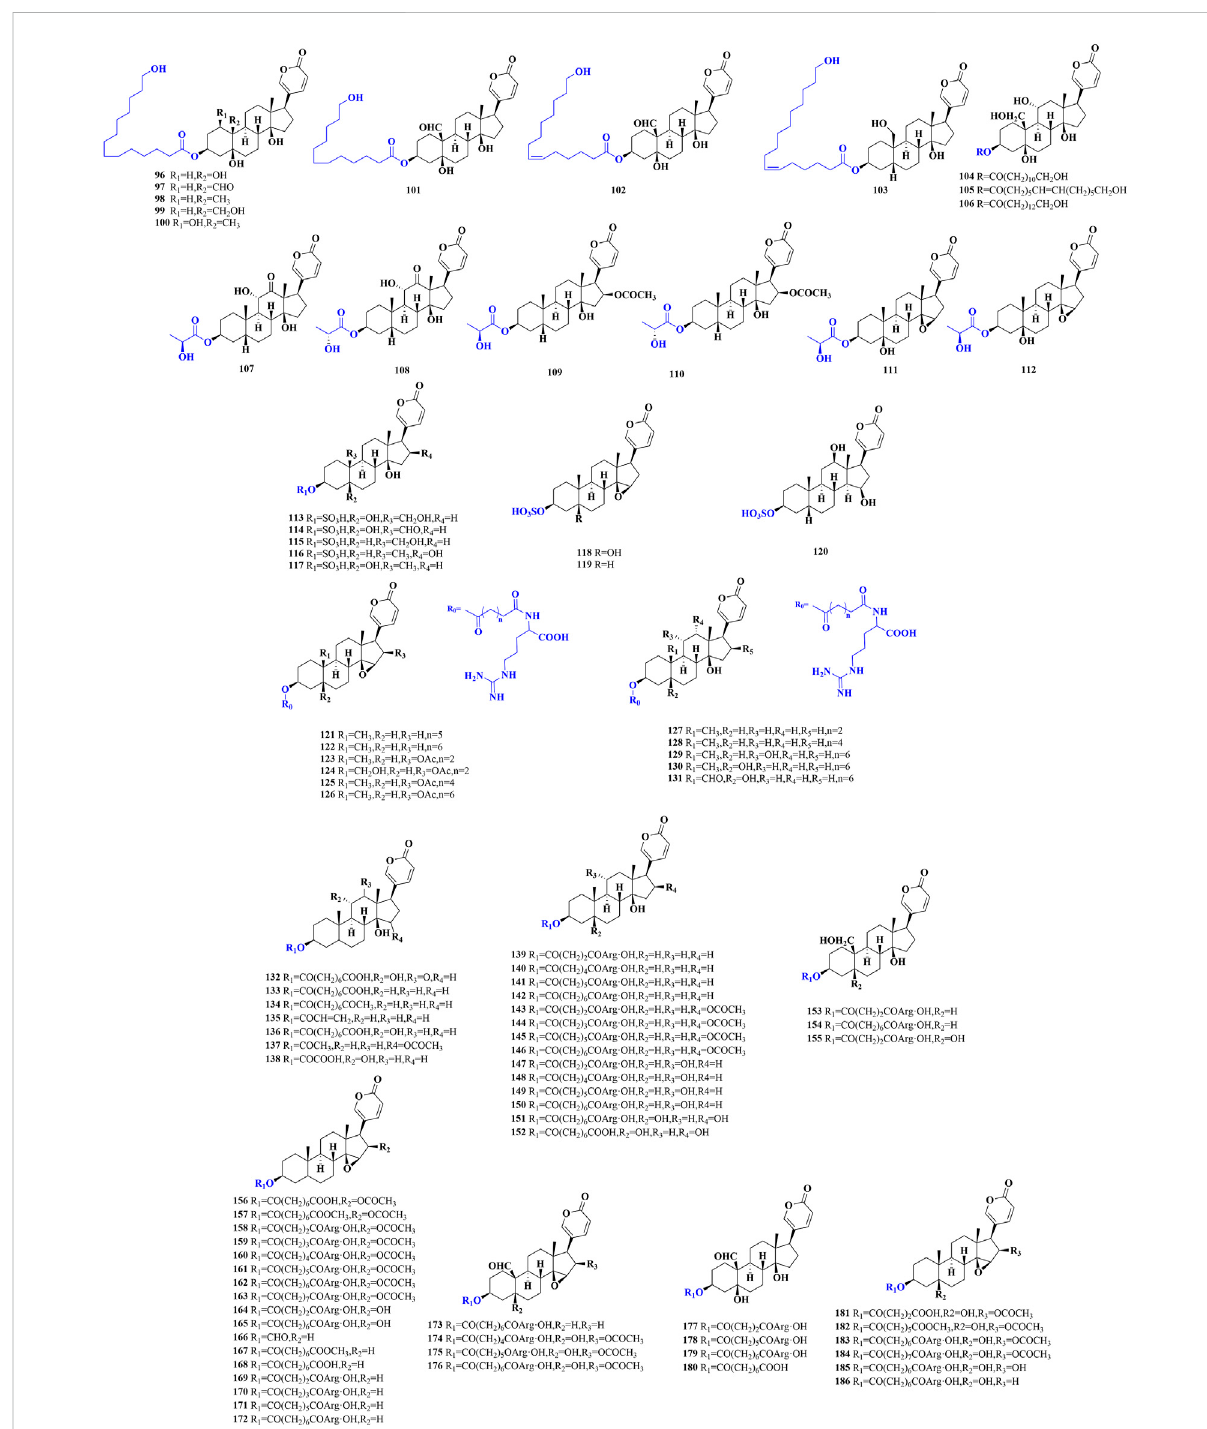
FIGURE 3 The chemical structures of reported conjugated